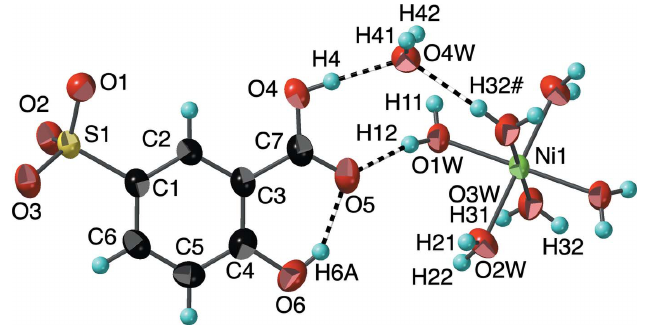
Figure 1 The molecular structure of (I), showing the atom-numbering scheme. Displacement ellipsoids are shown at the 90% probability level and hydrogen atoms are shown as small spheres of arbitrary radii. Hydrogen bonds are shown as striped cylinders. Symmetry-equivalent oxygen atoms are included to show the complete coordination environment of the cation. [Symmetry code: (#) 1 (cid:4) x , 2 (cid:4) y , (cid:4) z